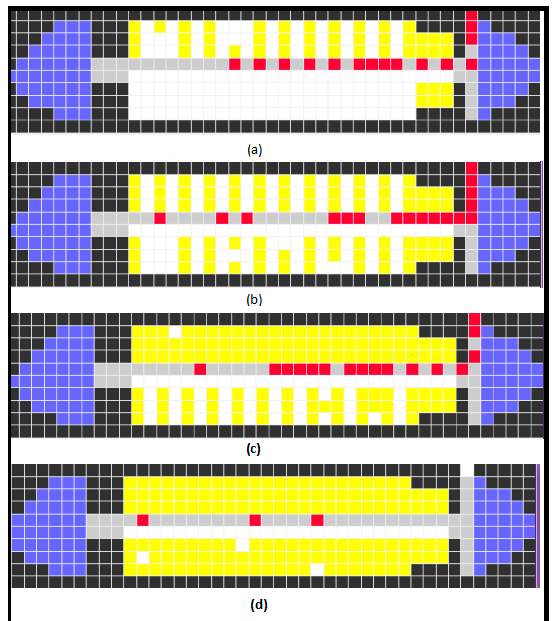
Figure 28. Optimal practical (every other row) strategy.